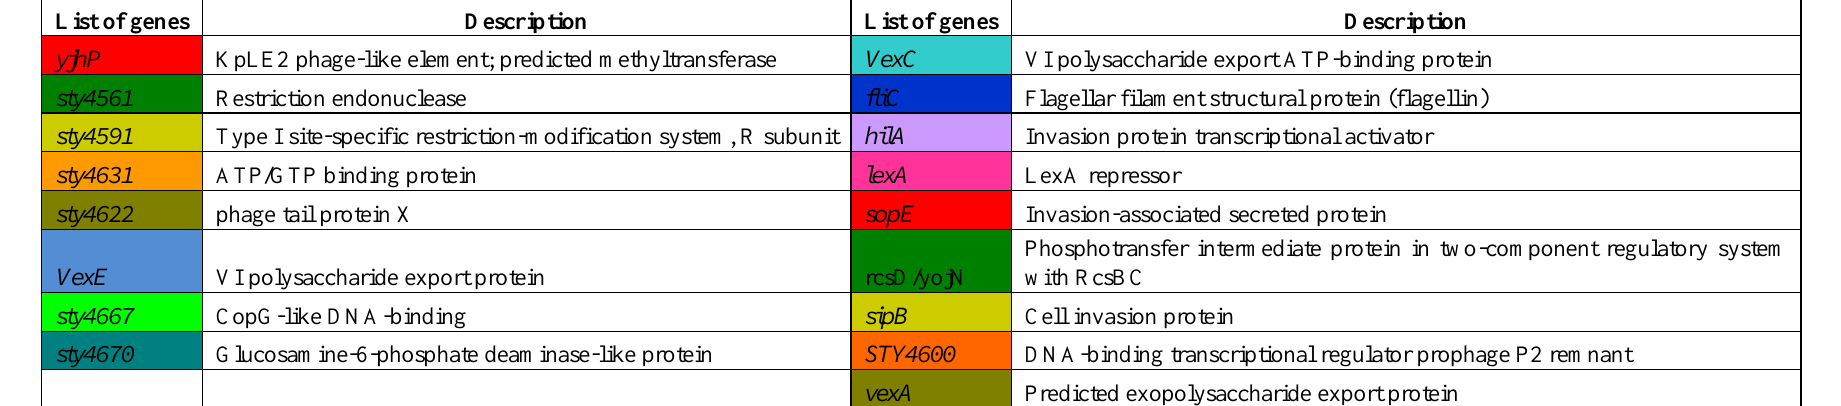
Table 9: Description for the genes in Figure 13. The colour of gene corresponds to the colour of the line in the gene expression graph in SPI-7. List of